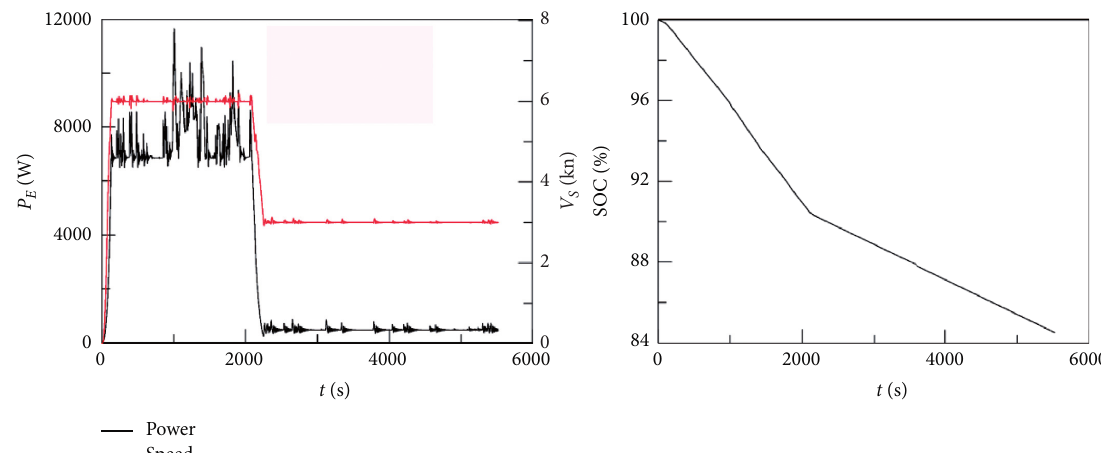
Figure 15: Results of the simulation on Route 3, highlighting speed, power, together with batteries SOC.